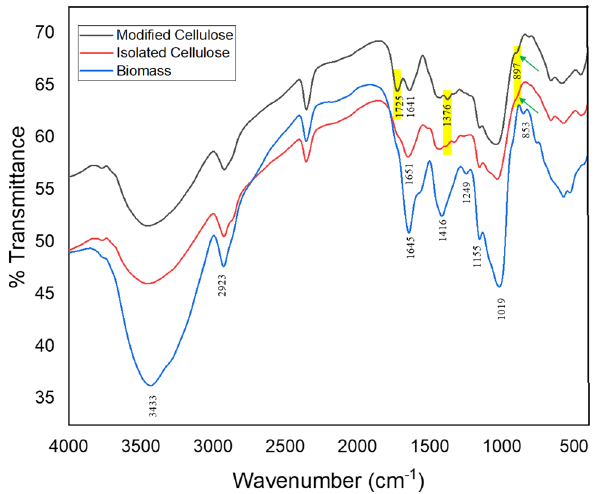
Figure 3. FT-IR spectra for the biomass ( Dioscorea bulbifera ), isolated and modified